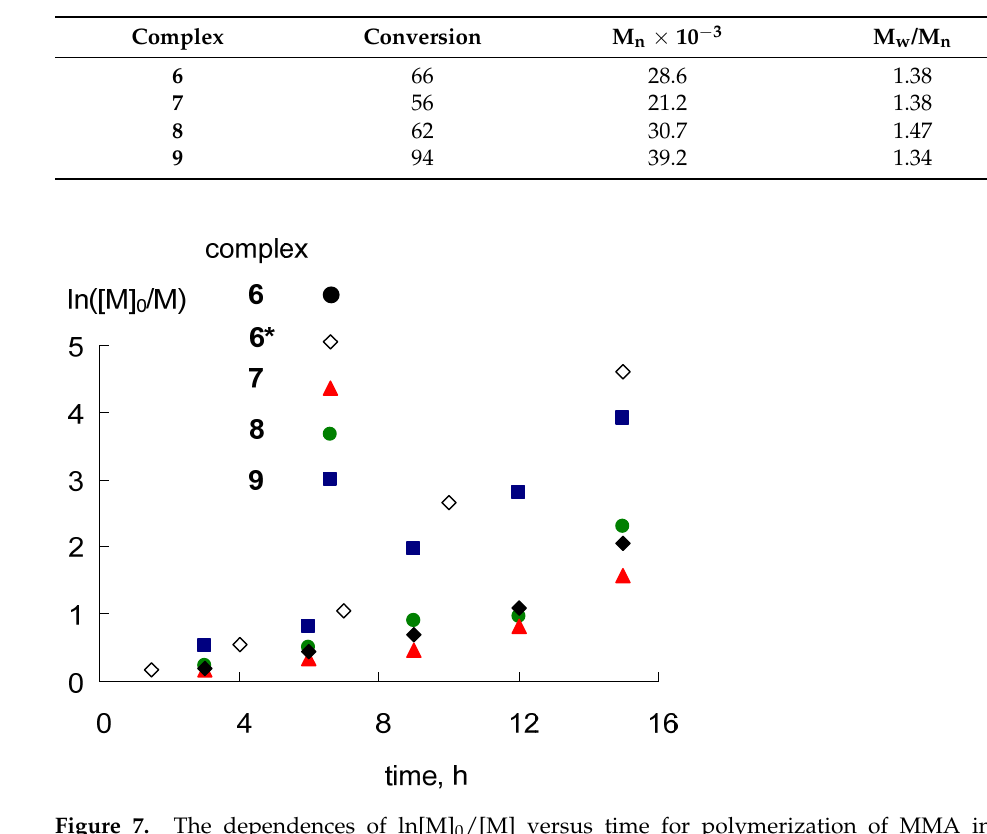
Table 3. The results of experiments on MMA polymerization in the presence of ruthenacaboranes 6 – 9 at 80 ◦ C. [MMA]:[CCl 4 ]:[Ru]:[i-PrNH 2 ] = 10,000:25:1:40. Polymerization time—12 h.